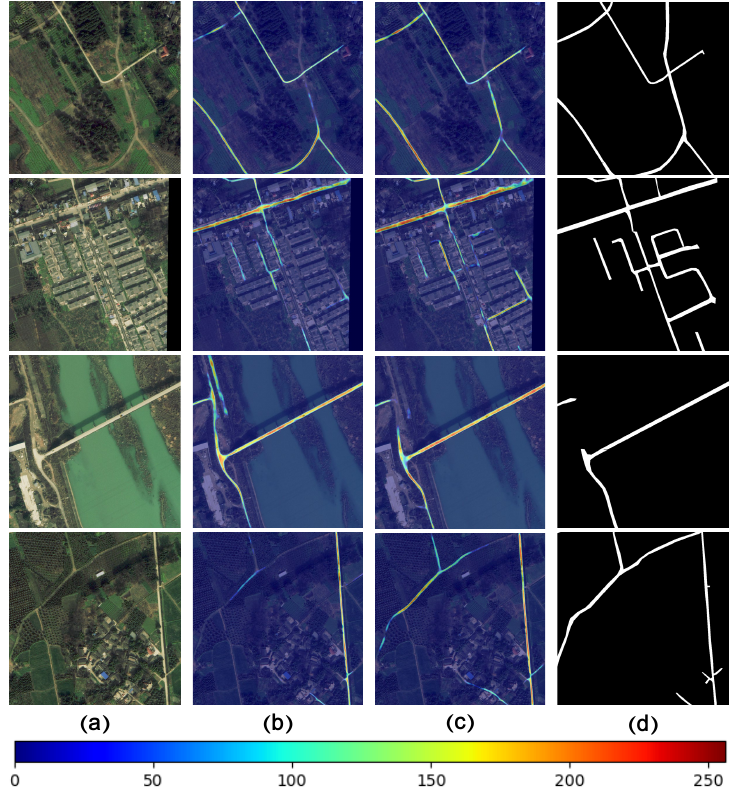
Figure 14. Grad-CAM visualization results for ( a ) the RGB image, ( b ) the result of fusing the RGB image with HRNet’s Grad-CAM mask, ( c ) the result of fusing the RGB image with MSFANet’s Grad-CAM mask and ( d ) the